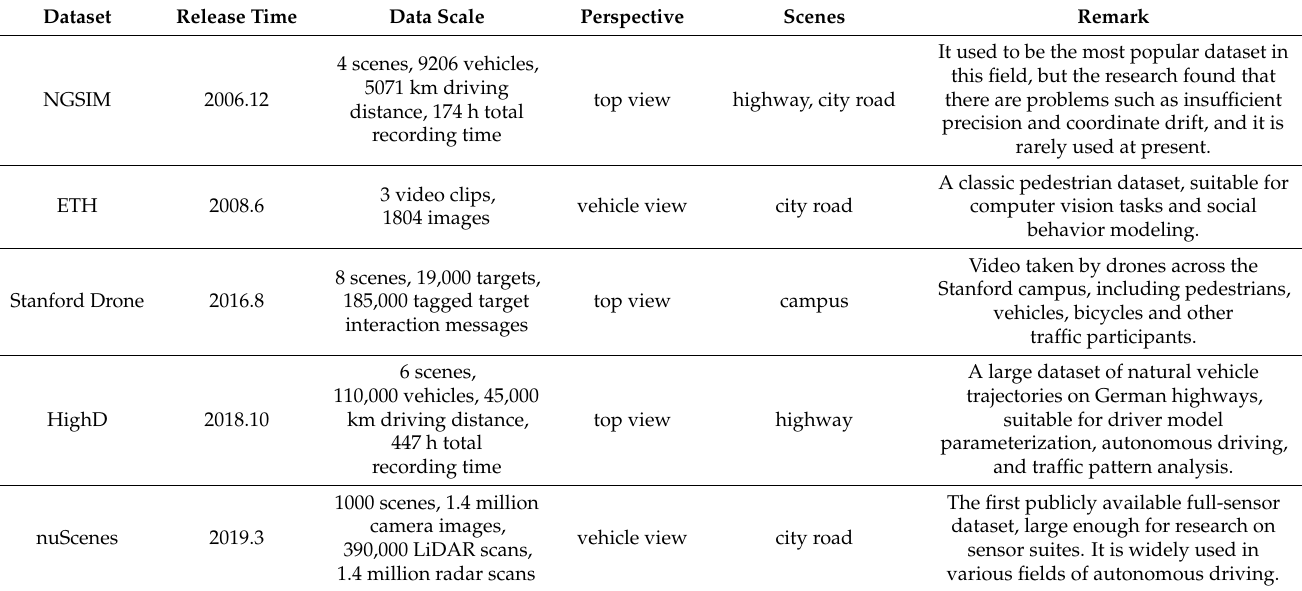
Table 2. Trajectory prediction related